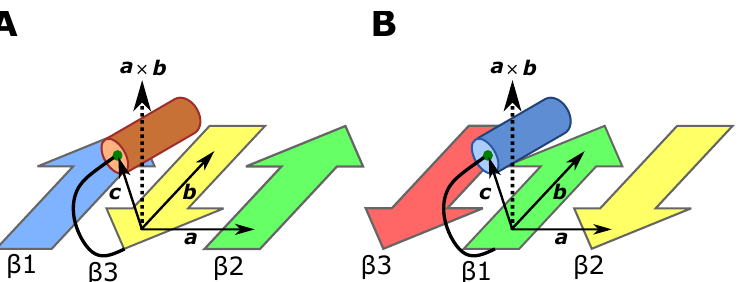
Figure 6. The method to judge on which side of the β -sheet the C or N-terminal α -helix lies. We defined three vectors, a , b , and c . The helix lies on the upper side of the β -sheet plane if ( a × b ) · c > 0 and the helix lies on the lower side of the plane if ( a × b ) · c < 0. ( A ) In the 1 ↑ 3 ↓ 2 ↑ + C-term α structure, the vector a is a vector extending from the C α atom of the C-terminal residue of the β - strand 3 (yellow arrow) to the C α atom of the N-terminal residue of the β -strand 2 (green arrow). The vector b is a vector extending from the C α atom of the C-terminal residue of the β -strand 3 to the C α atom of the second residue before the C-terminal residue of the β -strand 3. The vector c is a vector extending from the C α atom of the C-terminal residue of the β -strand 3 to the center of mass (green dot) of C α atoms of four N-terminal residues of the α -helix (orange cylinder). ( B ) In the 3 ↓ 1 ↑ 2 ↓ + N-term α structure, the vector a is a vector extending from the C α atom of the N-terminal residue of the β -strand 1 (green arrow) to the C α atom of the C-terminal residue of the β -strand 2 (yellow arrow). The vector b is a vector extending from the C α atom of the N-terminal residue of the β -strand 1 to the C α atom of the second residue after the N-terminal residue of the β -strand 1. The vector c is a vector extending from the C α atom of the N-terminal residue of the β -strand 1 to the center of mass (green dot) of C α atoms of four C-terminal residues of the α -helix (blue